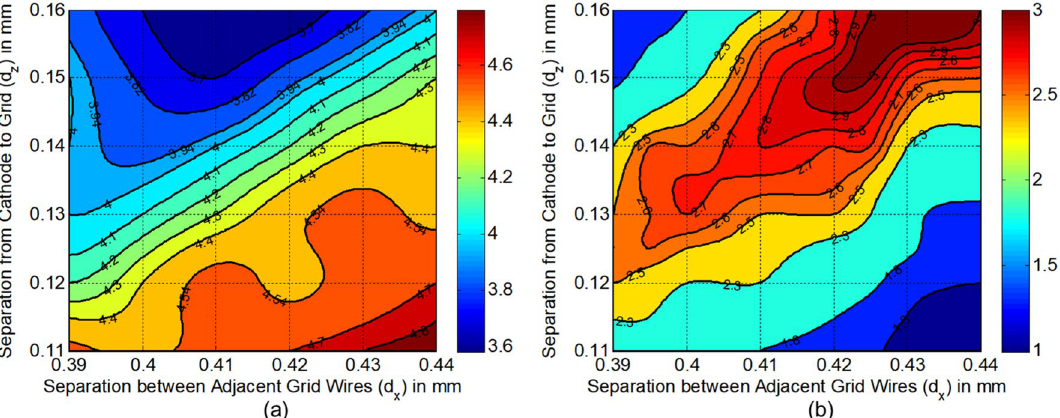
Figure 10. ( a ) Variation of throw distance in y direction Z mY with both d x and d z . ( b ) Variation of throw distance in x direction Z mX with both d x and d z